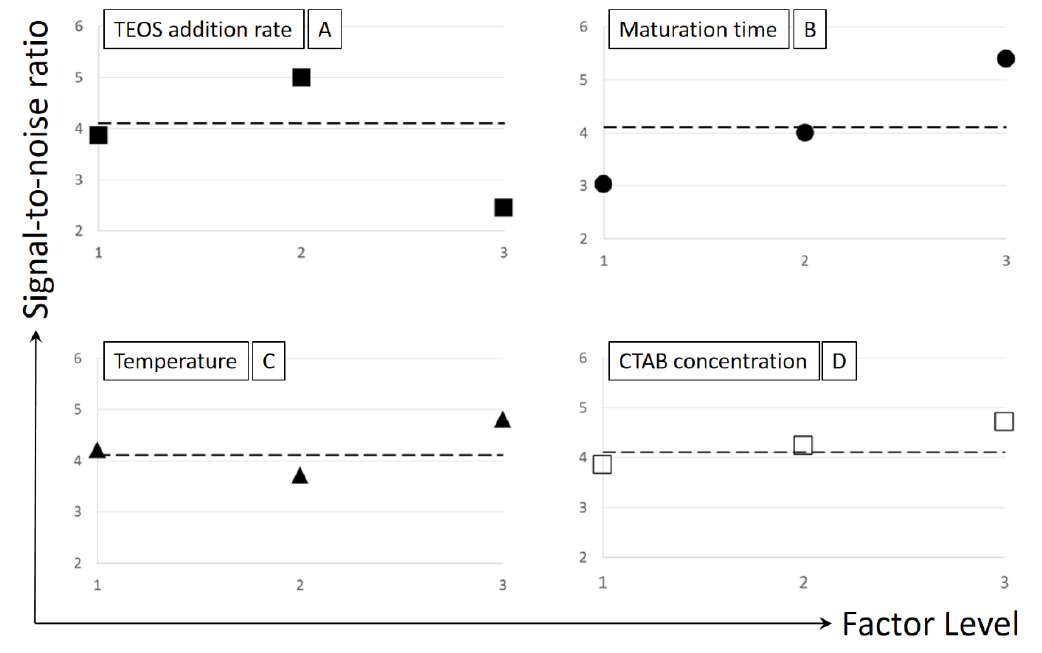
Figure 1. Effect of the variables or factors on the particle size according to the Taguchi L9 matrix: S/N ratio values versus level or value of each factor. Factors: ( A ) TEOS addition rate; ( B ) Maturation time; ( C ) Temperature; ( D ) Surfactant or CTAB concentration.